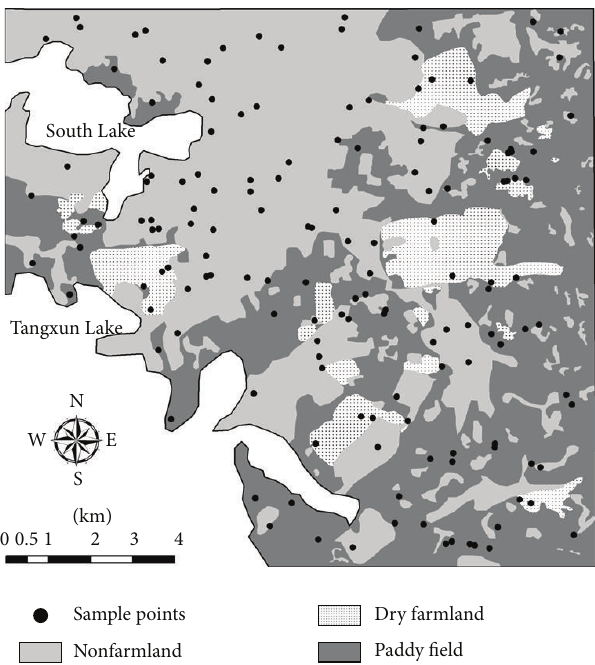
Figure 1: Soil sample locations and land use type distribution.